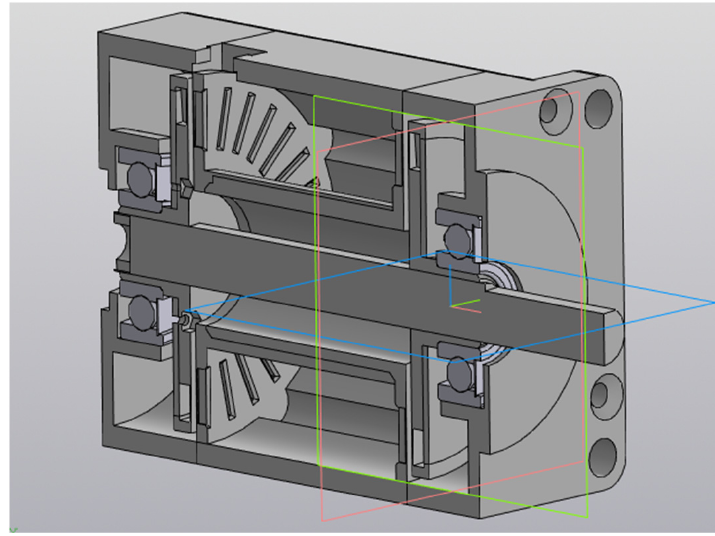
Figure 8. Mockup of the motor.